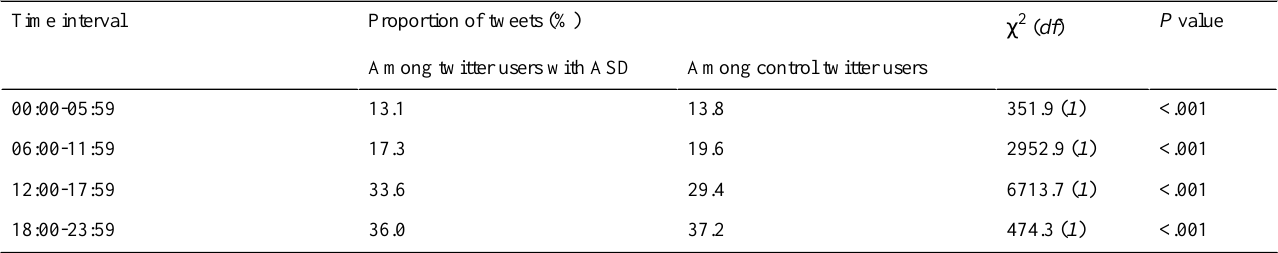
P value χ 2 ( df )Proportion of tweets (%)Time interval